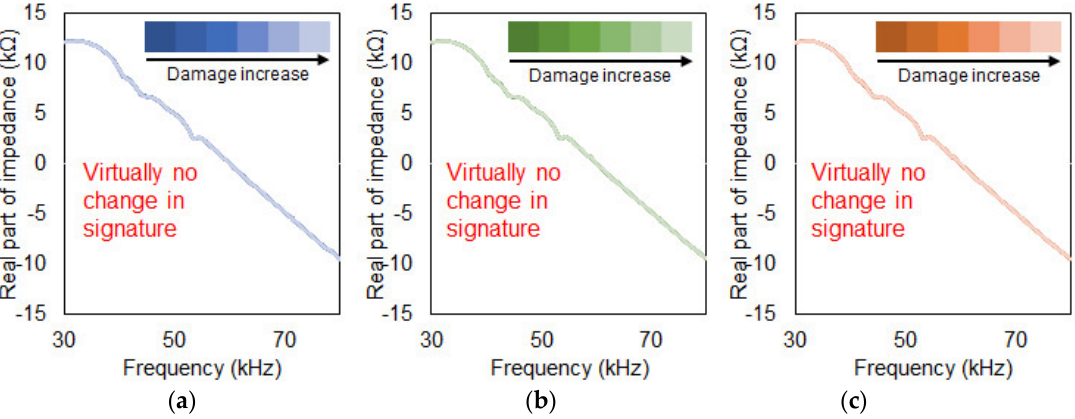
Figure 6. Increasing damage at a fixed location. ( a ) Conventional PZT attachment; ( b ) Steel wire PZT attachment; ( c ) Metal disc PZT attachment.